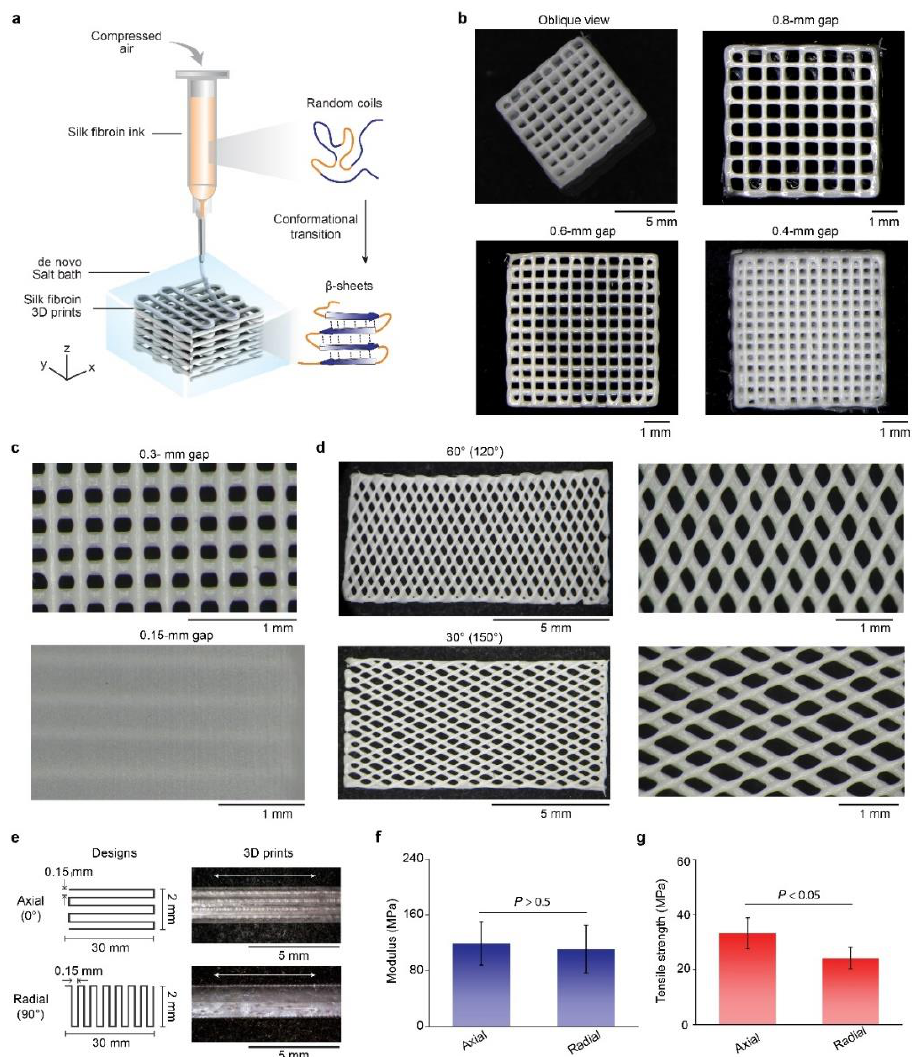
Figure 2. Representative 3D prints with silk fibroin inks. ( a ) Schematic of 3D printing with silk fibroin inks using a salt bath. Silk fibroin transforms from random coils to β -sheet after printing due to the salt bath. ( b ) Optical images of four-layer rectangular lattices with filament gaps from 0.8 to 0.4 mm. ( c ) Optical images of two lattices with filament gaps of 0.3 and 0.15 mm. The latter exhibits closed pores and overlapped filaments, thus becoming a solid film. ( d ) Optical images of two rectangular lattices with distinct filament orientation, including 60° and 30°. ( e ) Design and optical images of two 3D-printed rectangular films (30-mm-long and 2-mm-wide) with 0.15-mm filament gaps and distinct filament orientations, such as axial (0°) and radial (90°). White double arrows indicate the direction of tensile strain. ( f , g ) Mechanical performance of the axial and radial films by uniaxial tensile tests, including Young’s modulus and tensile